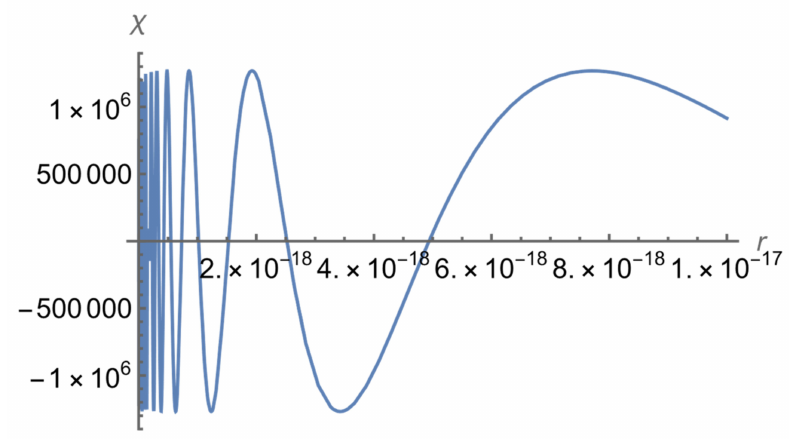
Figure 1. The normalized wave function of the bound E = 0 state of the neutron–muon system for L = 2 at a relatively small r.